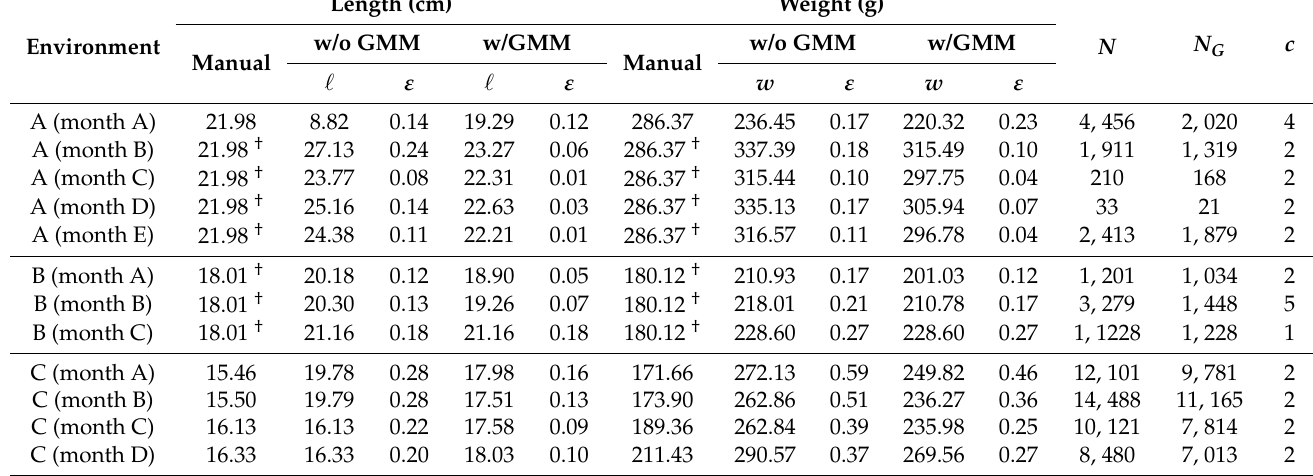
number of the instance in the largest Gaussian component, and the number of Gaussian components,